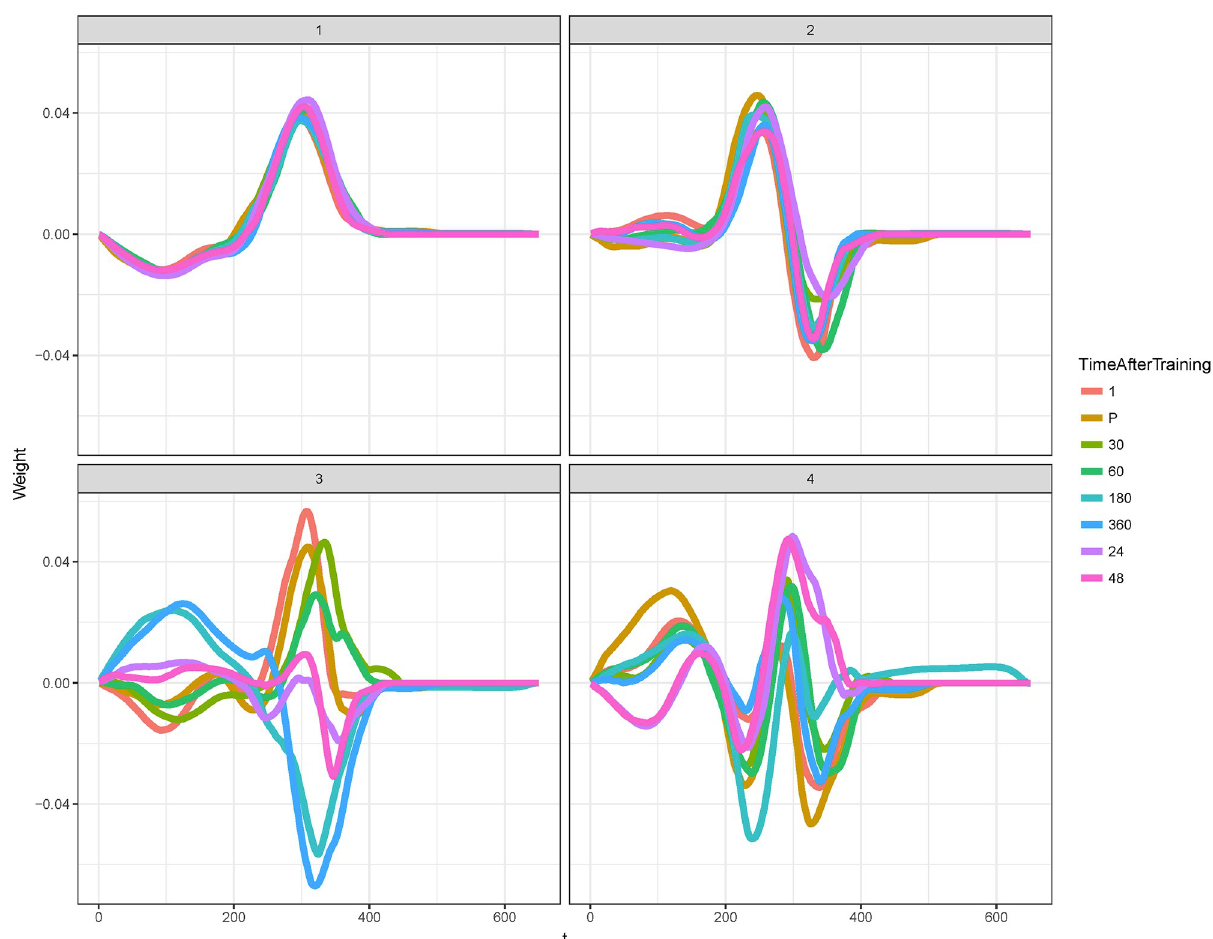
Fig 4. Variable loadings for PC1 to PC4 where each curve represents a stratified time point, the x axis the force-curve time and the y axis the force-curve weighting. PC1 and 2 represent averaging effects across time points, whereas PC3 and PC4 show contrasts between pre- to 1 h post- training, and 3 h to 48 h post-training. Note also the occurrence of contrasts at the beginning and around the peak of the curve for PC3 and PC4.